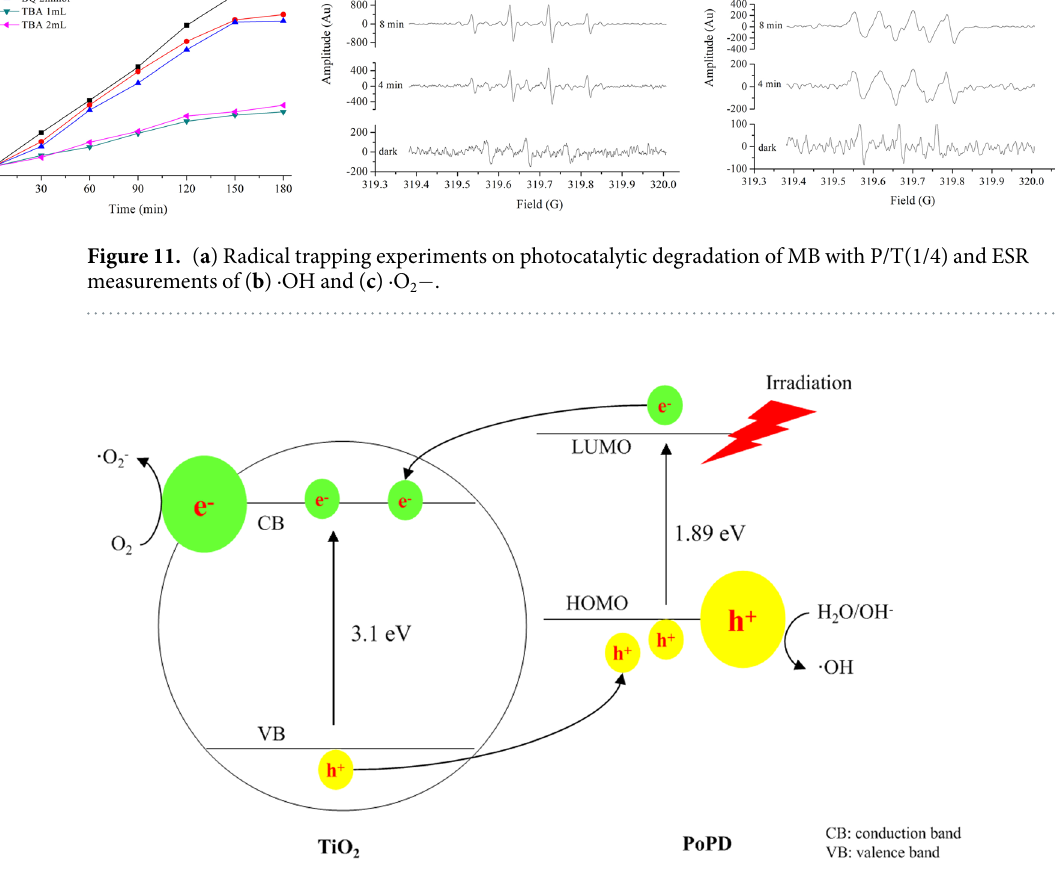
Figure 12. The photocatalytic mechanism of the PoPD/TiO 2